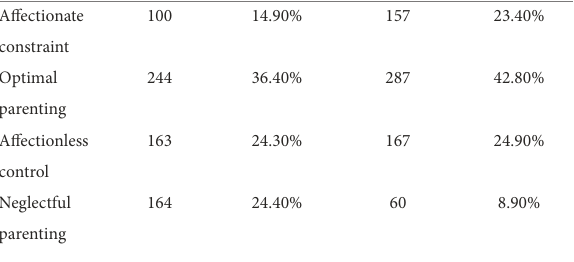
TABLE 2 Percentages related to parenting style groups in the sample.